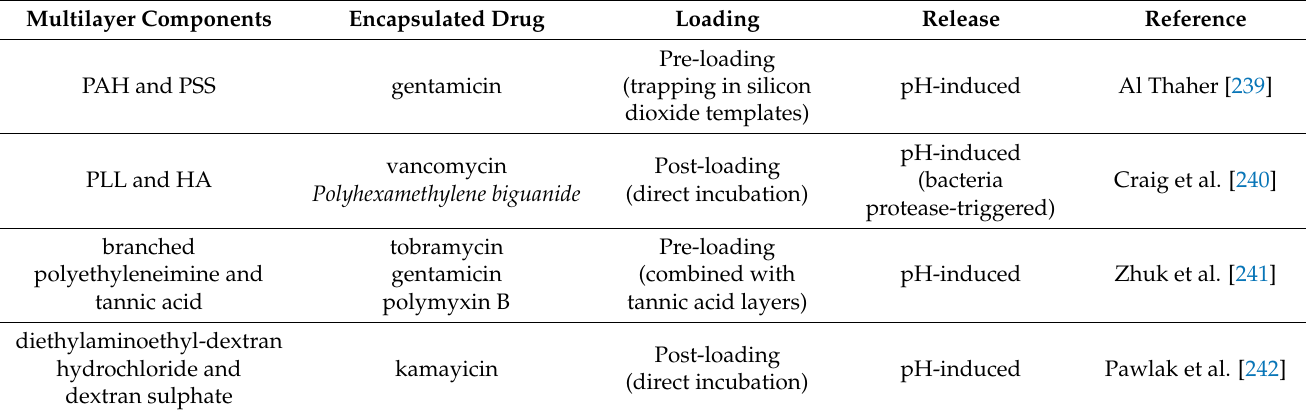
Table 1. Summary of multilayered capsules used for antibiotic